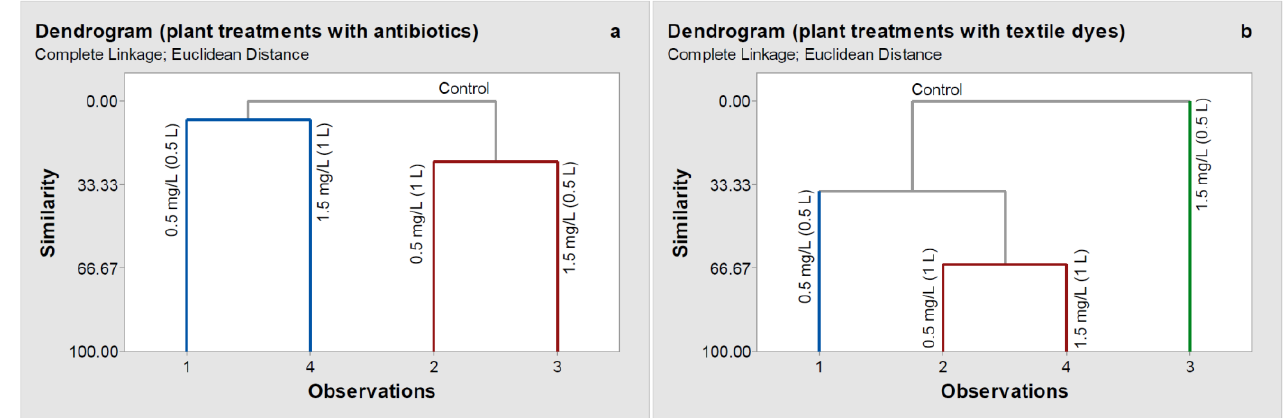
Figure 3. Hierarchical clustering dendrograms for leaf carotenoid contents (violaxanthin and neoxanthin) in wheat treated with antibiotics ( a ) and textile dyes ( b ). The dendrograms were created by the complete linkage method.